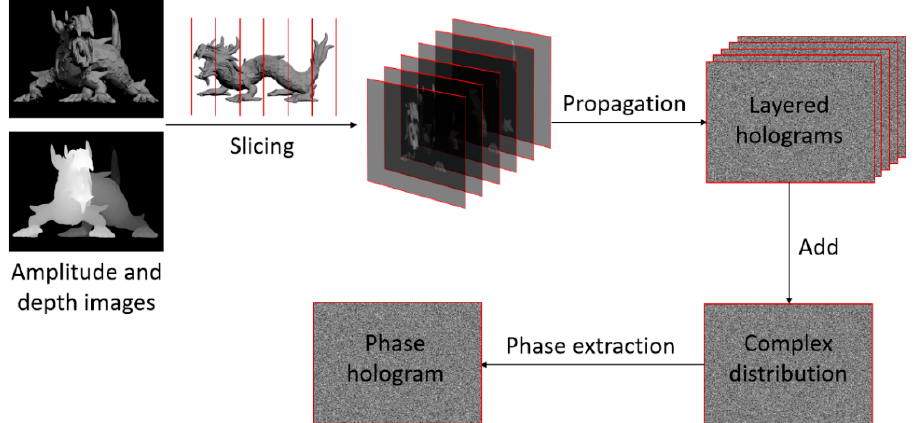
Figure 3. Diagram of the layer-based shifted Fresnel diffraction for 3D computer-generated holograms (CGHs) calculations.